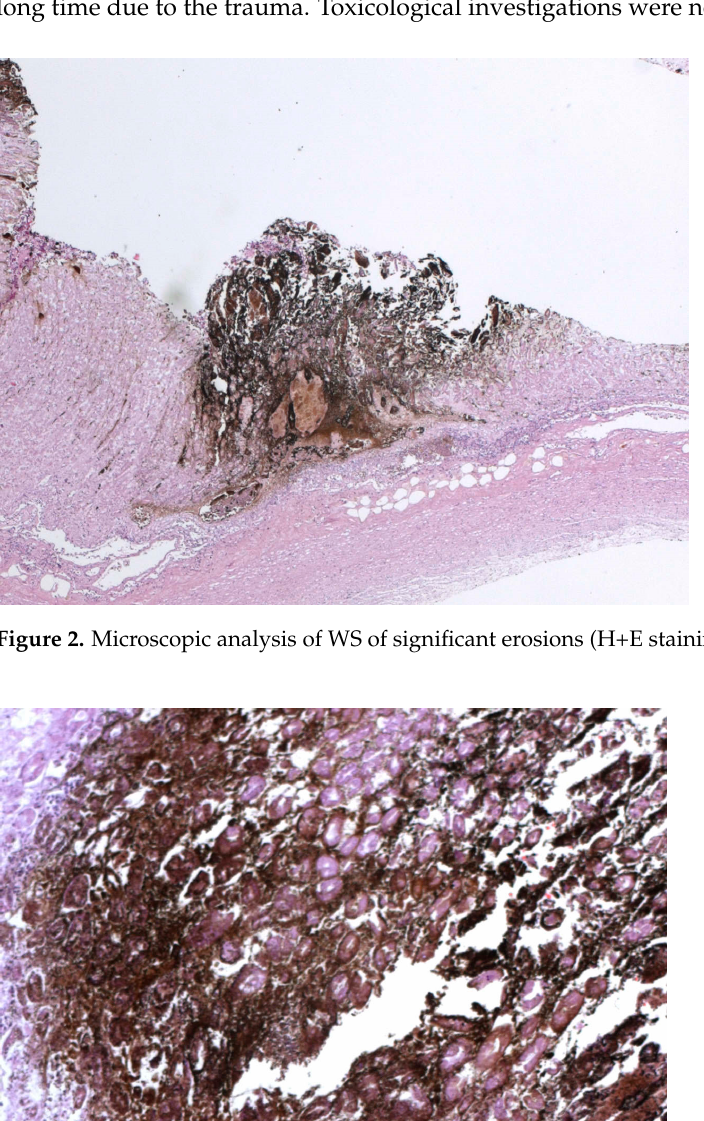
Figure 2. Microscopic analysis of WS of significant erosions (H+E staining).